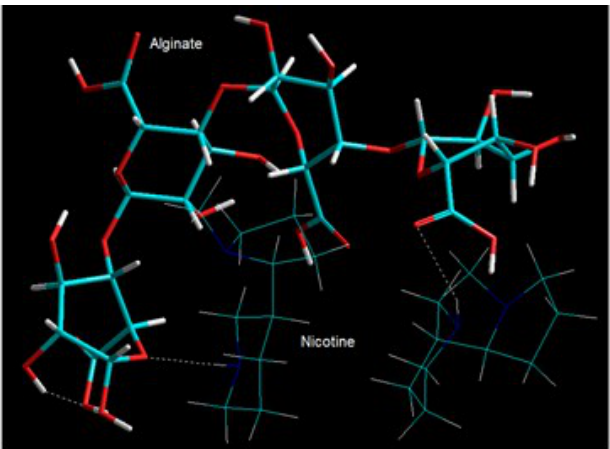
Figure 4. Visualization of geometrical preferences of nicotine in complexation with alginate after molecular mechanics simulations. Color codes: C (cyan), O (red), N (blue), and H (white). Table 2. Calculated molecular attributes of the complexes involving alginate (ALG) and nicotine (NCT). Molecular Structure